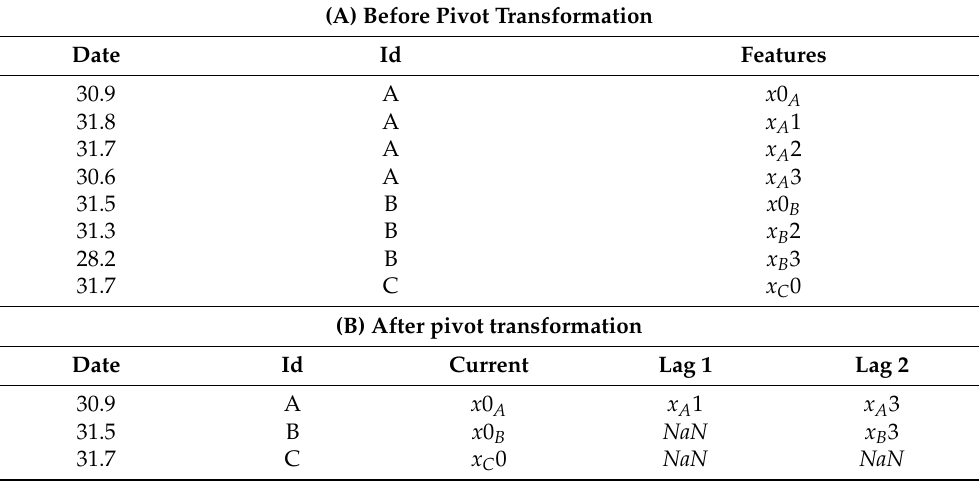
Table 2. Illustration of the pivot transformation used on the mainfile dataset. x ij represents an observation (array of feature values) for customer j at time i , where i = 0 indicates the last observation present in the data. Observe how customer A has four consecutive rows of data, and thus no NaN values after the transformation, whereas customer B misses an observation at time T − 1 and thus has NaN values for the lags of 1.